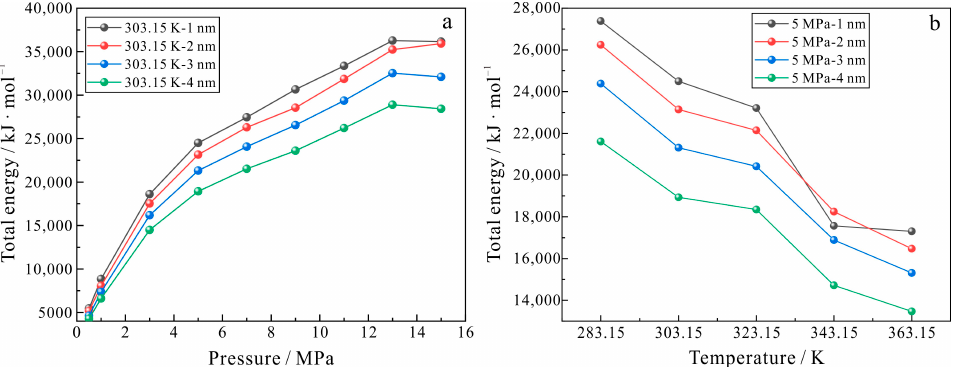
Figure 14. Total energy for FK–3 coal, calculated from molecular dynamics simulations, as function of methane pressure ( a ) and temperature ( b ).